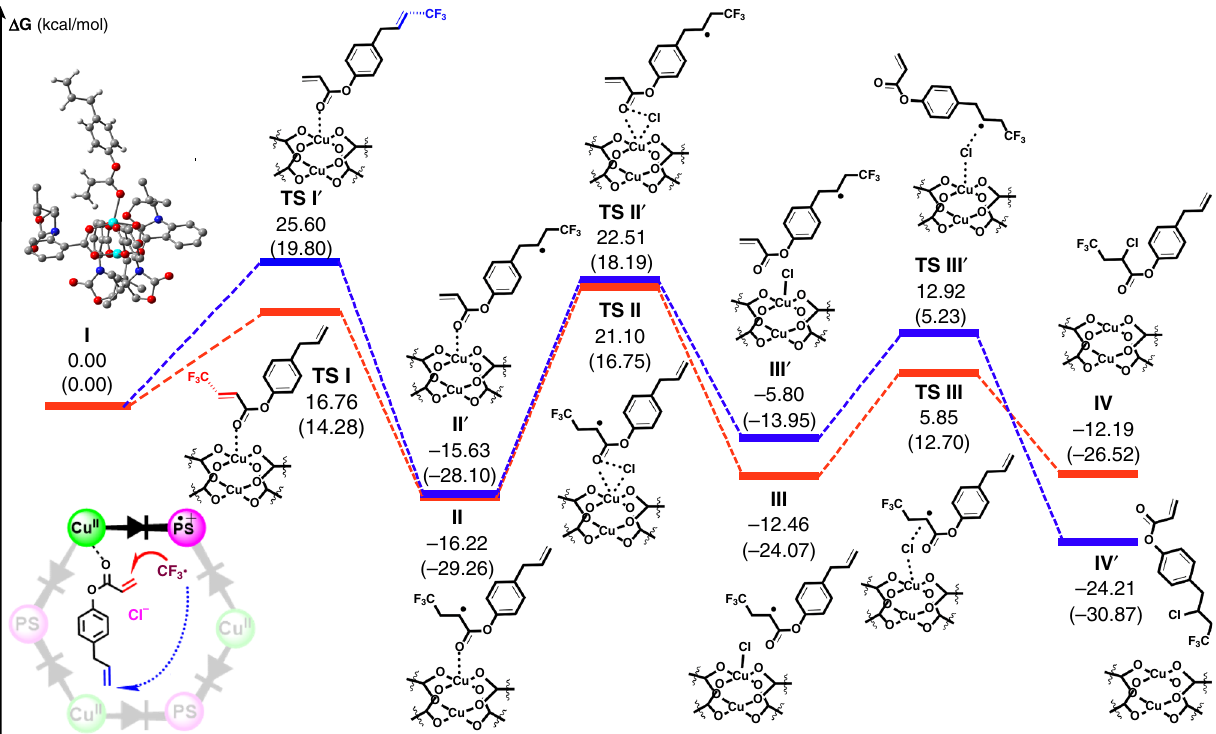
Fig. 9 DFT study on the site selectivity. The computed relative free energies and electronic energies (in parentheses) are given in kcal mol − 1 . Inset, upper left (intermediate I ): simpli fi ed DFT model of 7l adsorbed on the Cu(II) node. Cu cyan, C grey, O red, N blue. Inset, lower left: conceptual illustration of the product-like late transition